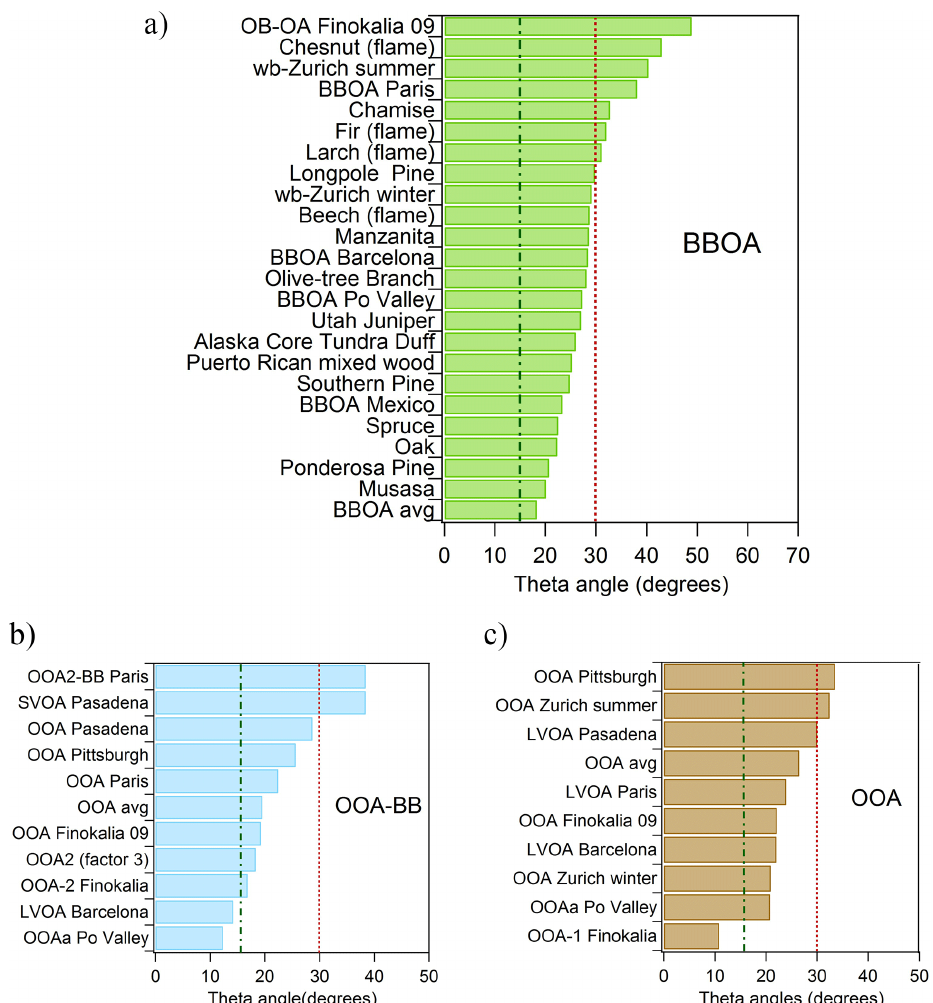
Fig. 6. Comparison (theta angles) between the identified factors of this study with relative organic aerosol spectra (color-coded by PMF solution): (a) fresh biomass-burning factor, (b) aged biomass-burning factor, and (c) oxygenated organic aerosol factor. The dashed lines represent the limits between good, moderate and poor